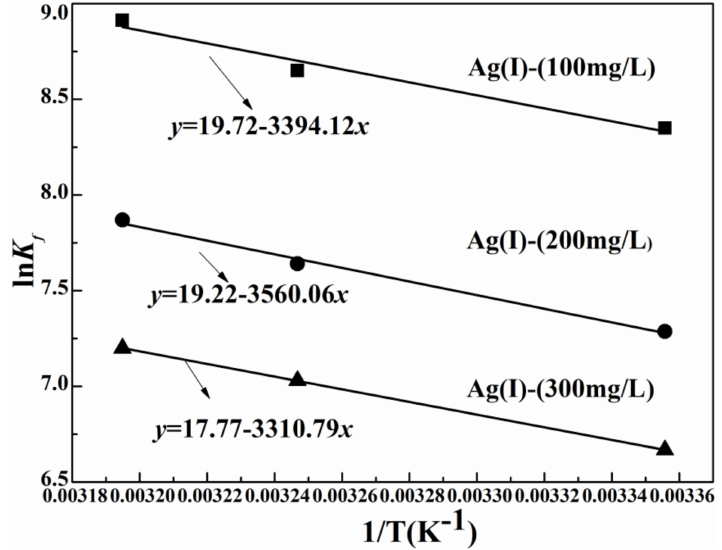
Figure 12. Effect of temperature on the Ag(I) adsorption